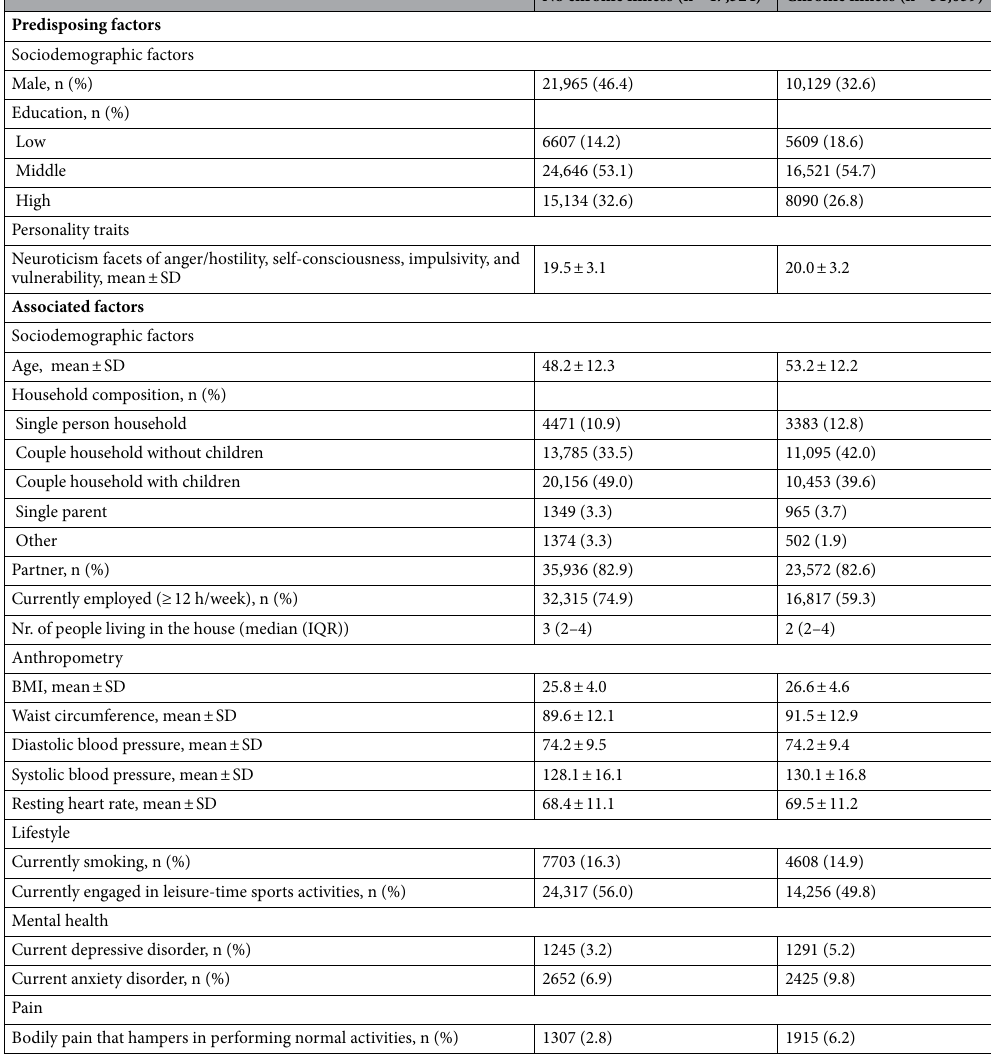
Table 1. Baseline characteristics of participants with and without a chronic disease (n = 78,363). n number; SD standard deviation, IQR interquartile range, BMI body mass